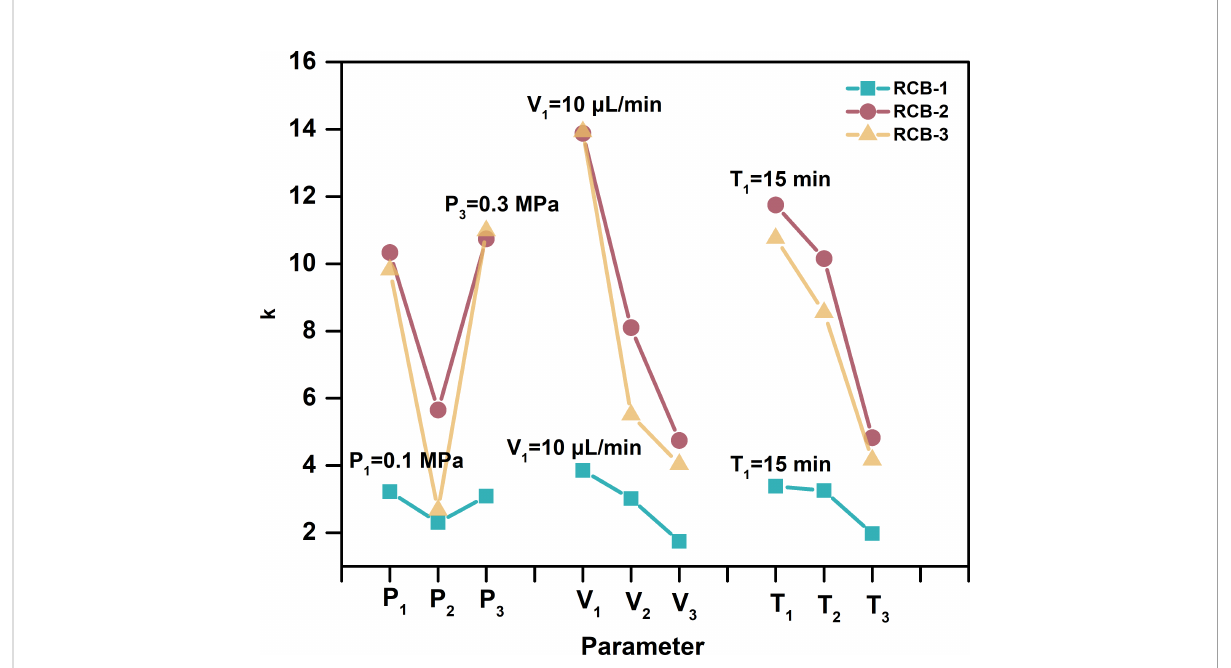
FIGURE 1 The optimization of the EFASS parameters by an orthogonal design of three factors and three levels. The Nitrogen pressure was 0.1 MPa, 0.2 MPa, and 0.3 MPa. The spraying velocity was 10 m L/min, 20 m L/min, and 30 m L/min, and the spraying time was 15 min, 30 min, and 45 min,